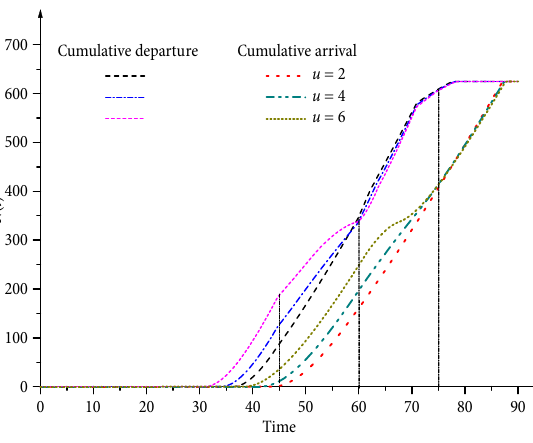
Fig. 9. Cumulative N- curves for the second type of toll profiles